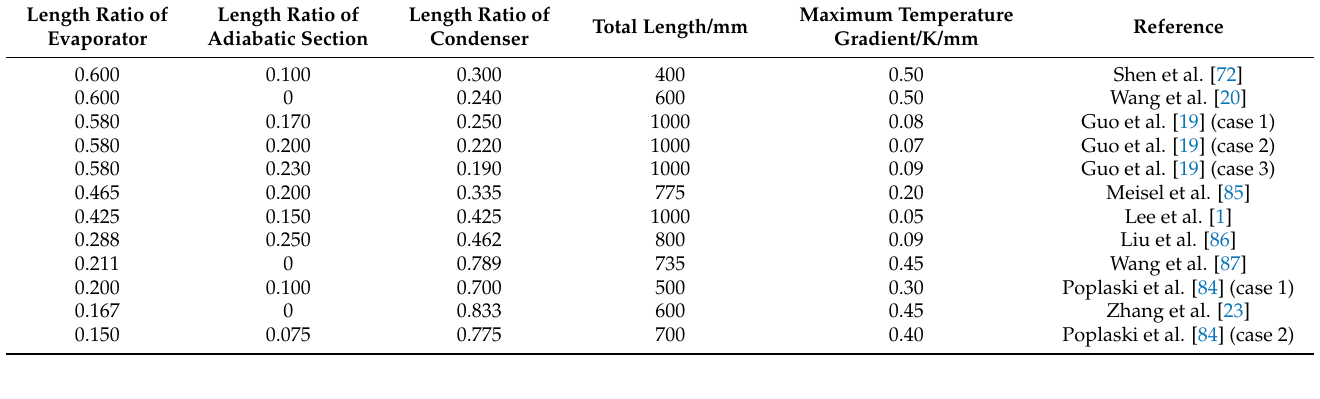
Table 7. Effect of the isothermal performance on length ratio of each section of heat pipes.